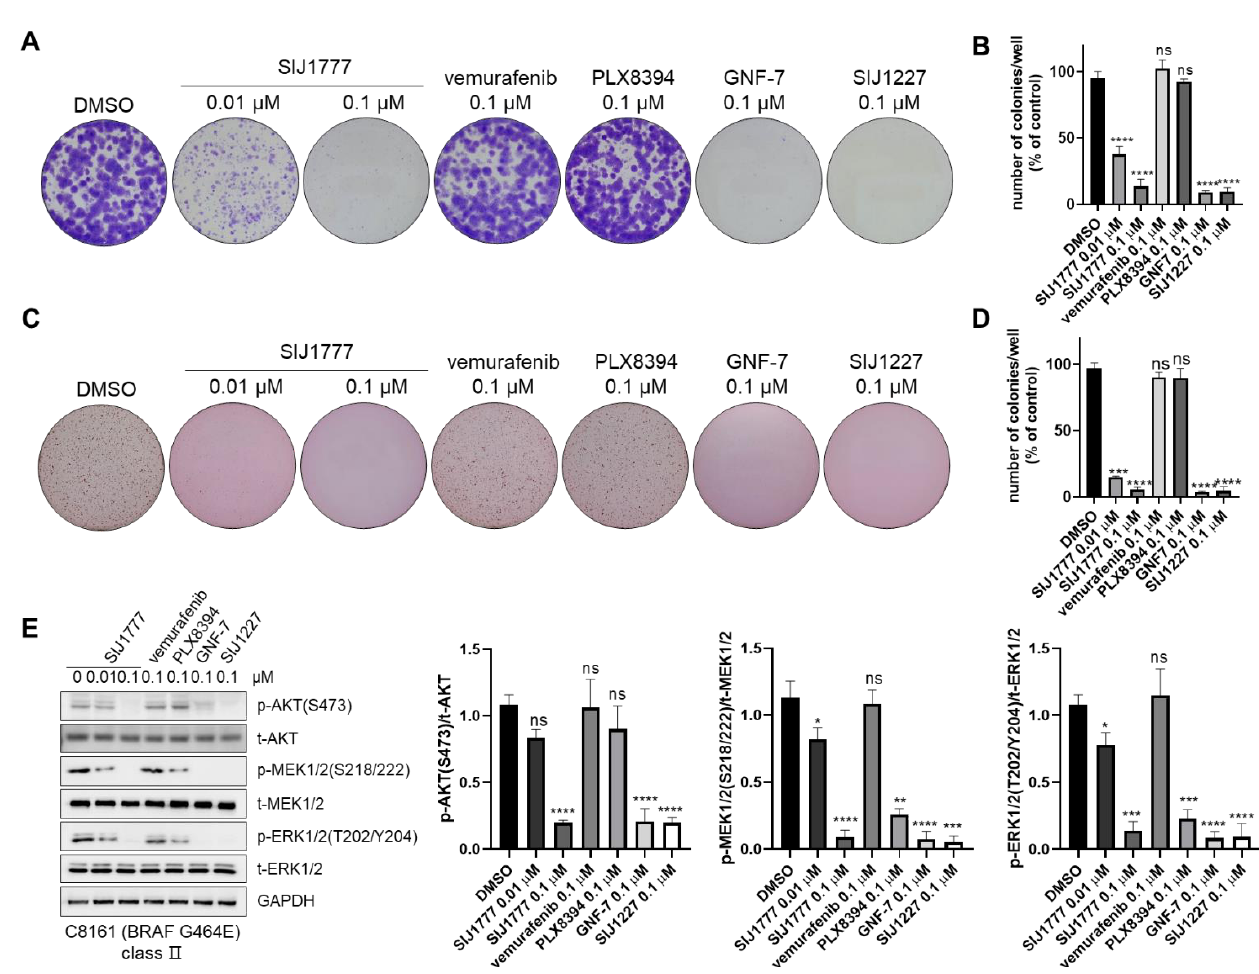
Figure 6. Clonogenic assay analysis of SIJ1777 in C8161. ( A , B ) 2D clonogenic assay (colony formation assay) results of the compounds on C8161 melanoma cell. After incubation with test compounds for 14 days, colonies were photographed without magnification. ( C , D ) 3D clonogenic assay (soft agar assay) results of test compounds on C8161 melanoma cell. Cells embedded within 0.35% low melting agar and incubated with the indicated compounds for 14 days and observed without magnification. ( B , D ) Number of colonies were determined automatically by ImageJ ( n = 3, respectively). ( E ) Western blot analysis of SIJ1777 in C8161. Cells were treated with 0.01, 0.1 μM of SIJ1777, and 0.1 μM of vemurafenib, PLX8394, GNF-7, and SIJ1227 for 24 h. Cell lysates were subjected to western blot analysis to estimate the phospho- or total- form of AKT, MEK, ERK levels, and GAPDH was used as the internal loading controls (left panel). Quantification result ( n = 3) of western blot result by ImageJ (right panel). Statistical significances were determined using a one-way ANOVA analysis (* p < 0.05, ** p < 0.01, *** p < 0.001, **** p < 0.0001).